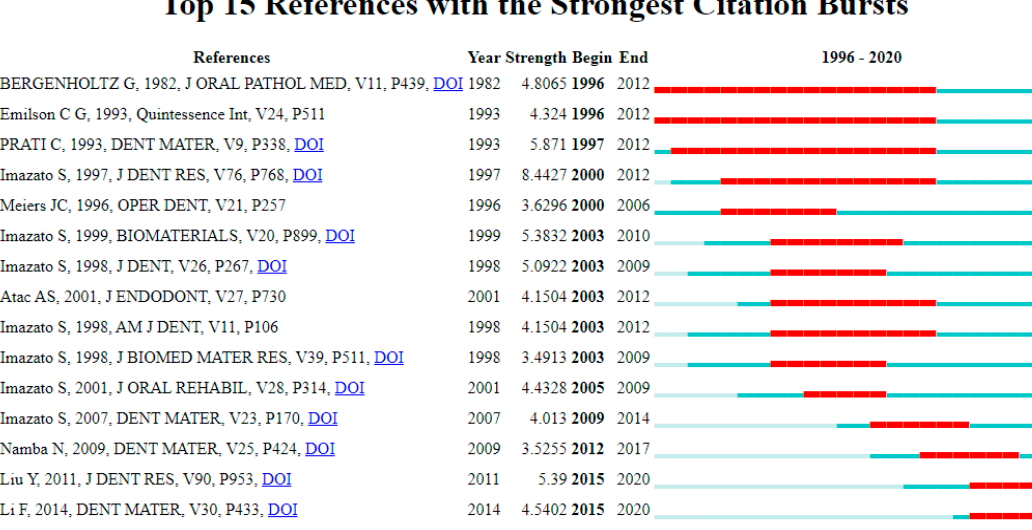
Figure 8. Citation bursts of dental adhesive articles (1996–2020).